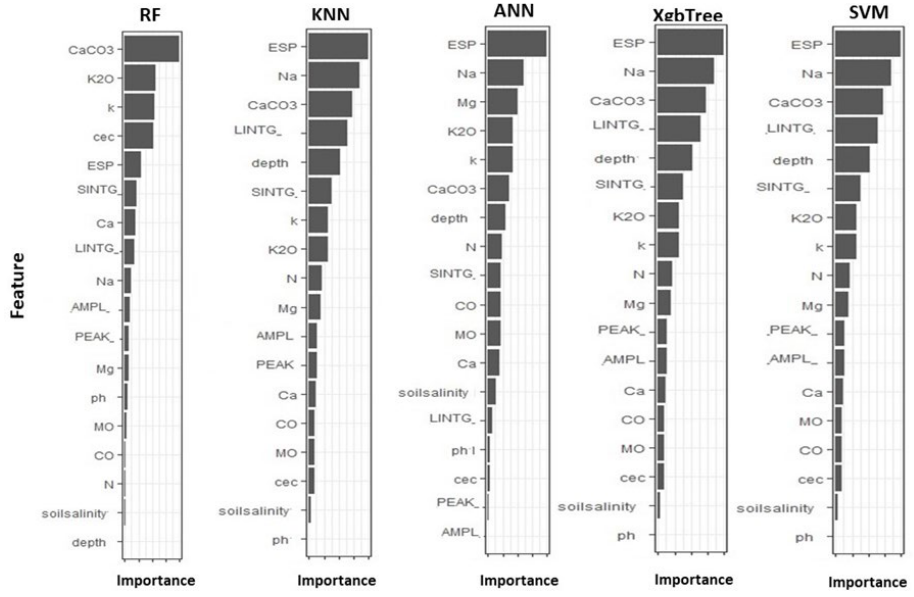
Table 3. The percentage of suitability classes in the five models.